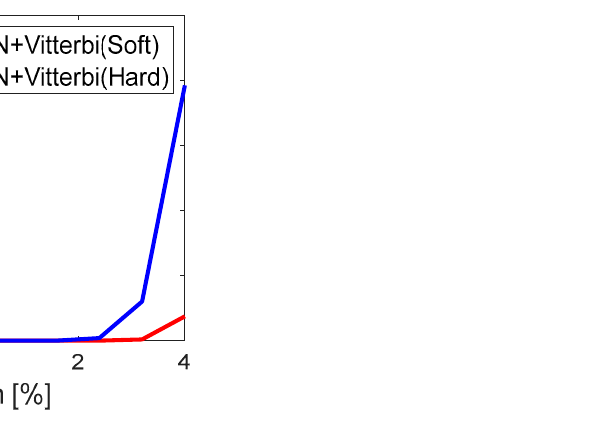
Figure 17. Hard and soft NN-based FSK demodulator with Viterbi decoder. BER performance vs. 𝑒 (cid:3028)(cid:3029)(cid:3046) [%]